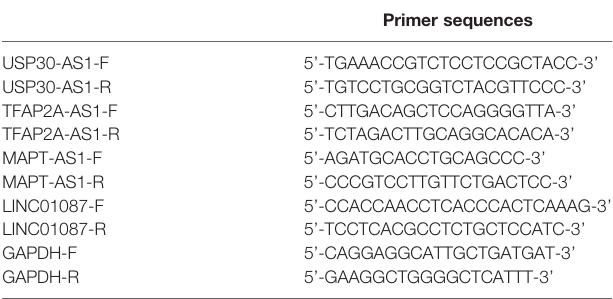
TABLE 1 | Primer sequences for RT-PCR analysis.